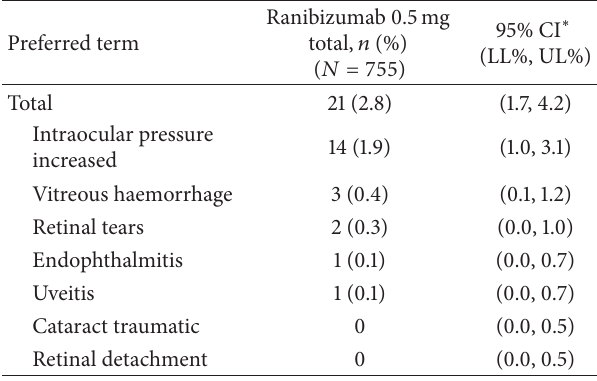
Table 3: Incidence of selected AEs over 2 years (safety set, first- treated